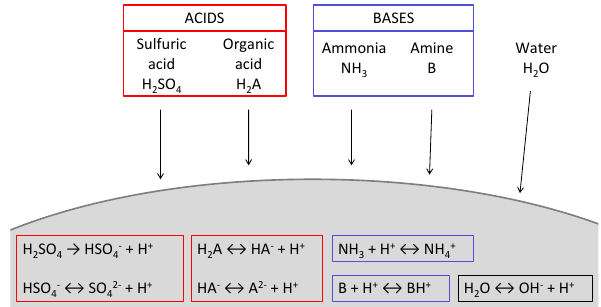
Fig. 1. Gas–liquid system modelled in this study with MABNAG. Two acids, two bases and water condense on the particle. In the particle phase, the dissociation/protonation produces ions and as a result 12 chemical species are included in the particle phase chem- istry